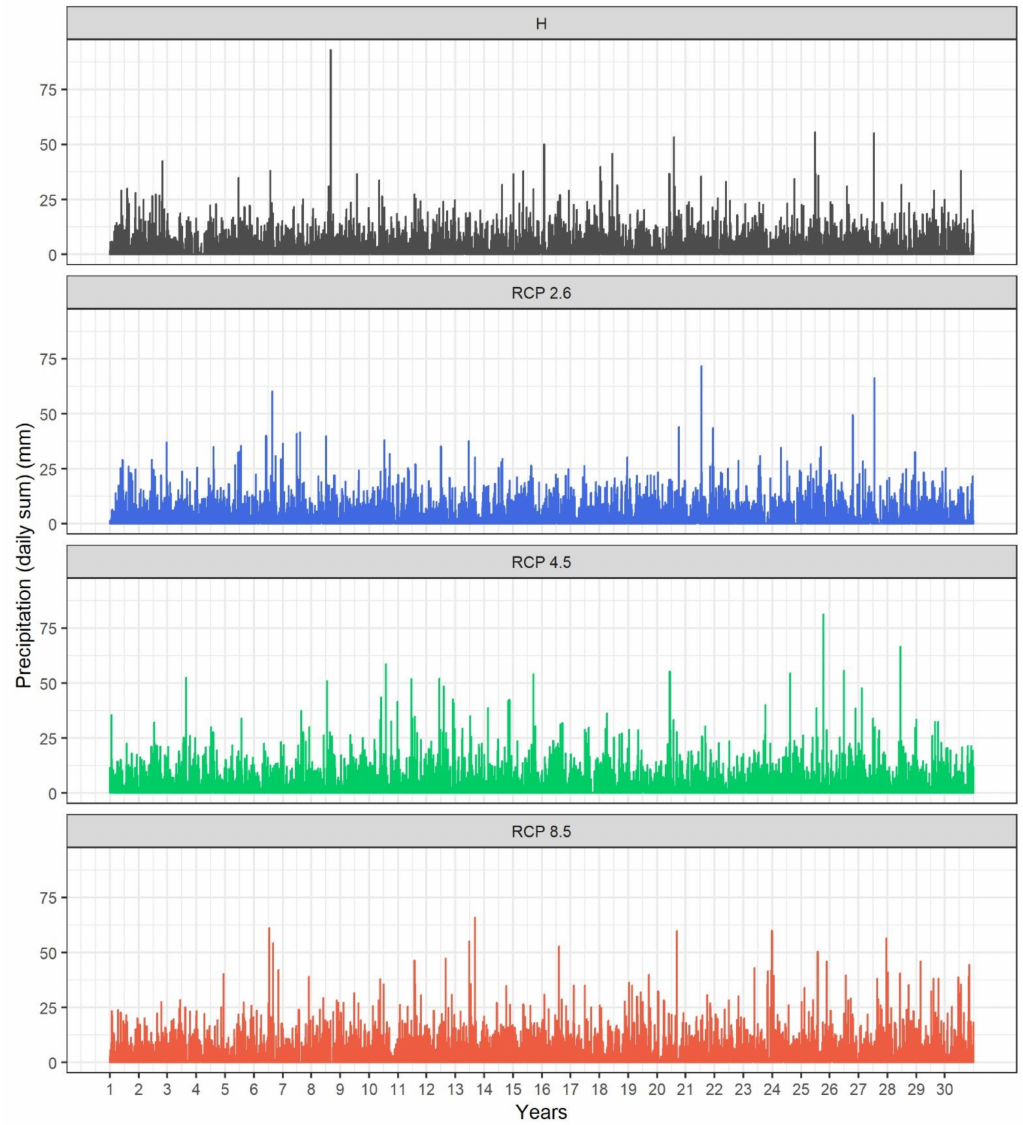
Figure A2. Daily total precipitation series for the historical period (H) and three RCP